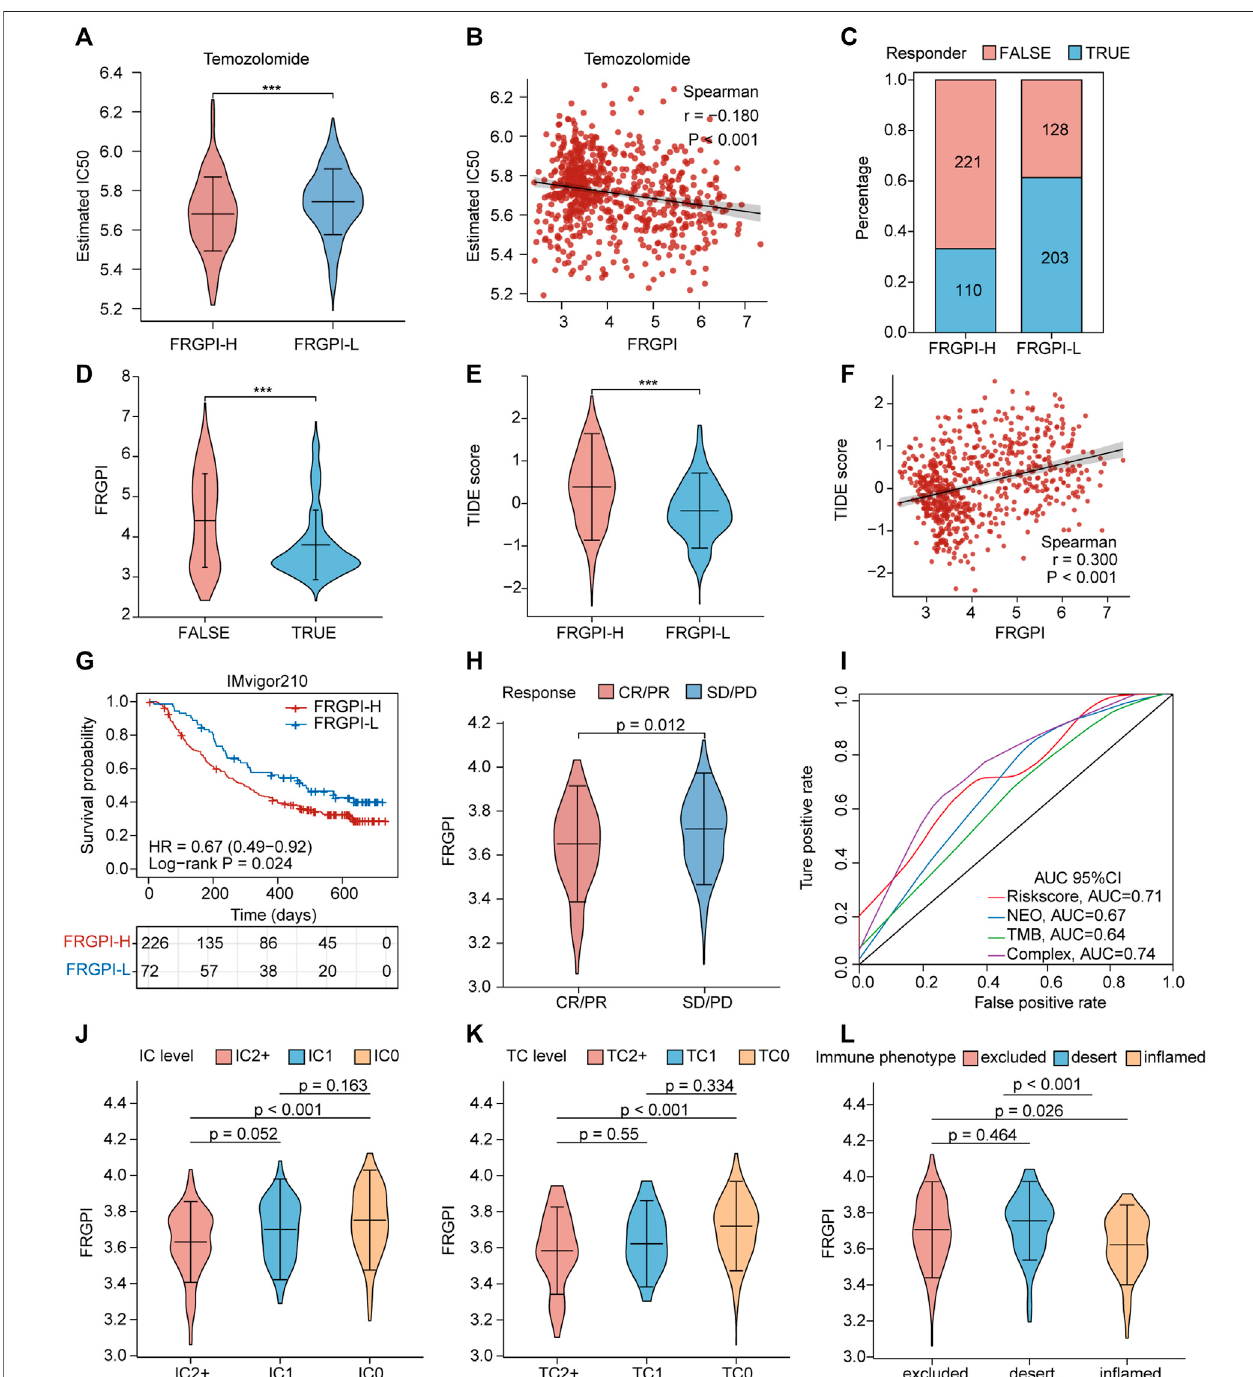
FIGURE 9 | FRGPI is predictive of temozolomide sensitivity and ICI response in glioma. (A) Different estimated temozolomide IC 50 between high and low FRGPI group. (B) ThespearmancorrelationbetweenFRGPIandestimatedtemozolomideIC 50 .TheICIresponseofeachpatientinhighandlowFRGPIgroupwaspredictedby TIDE algorithm, (C) stacked histogram showed thedistributionof “ TURE ” or “ FALSE ” responder inhigh and lowFRGPIgroup; (D,E) Violin plotsshowedthe FRGPIlevel of “ TURE ” - and “ FALSE ” -responder group, and the different TIDE score between high- and low-FRGPI group. (F) The spearman correlation between FRGPI and TIDEscore. (G) Kaplan – MeiercurvesshowingoverallsurvivalinpatientswithloworhighFRGPIintheanti- PD-L1 cohort. (H) ThedistributionofFRGPIindistinctanti- PD- L1 clinical response groups. (I) Roc curves showing predicting value of FRGPI, neoantigen (NEO), TMB and complex (FRGPI combined with NEO and TMB) group for anti- PD-L1 therapy response. CR, complete response; PD, disease progression, PR, partial response; SD, stable disease. (J – L) Distribution of the FRGPI in distinct IC- level,TC-levelandimmune-phenotypegrouprespectivelyintheanti- PD-L1 cohort.IC-level, PD-L1 expressionlevelonimmunecells;TC-level, PD-L1 expressionlevelon tumor cells.